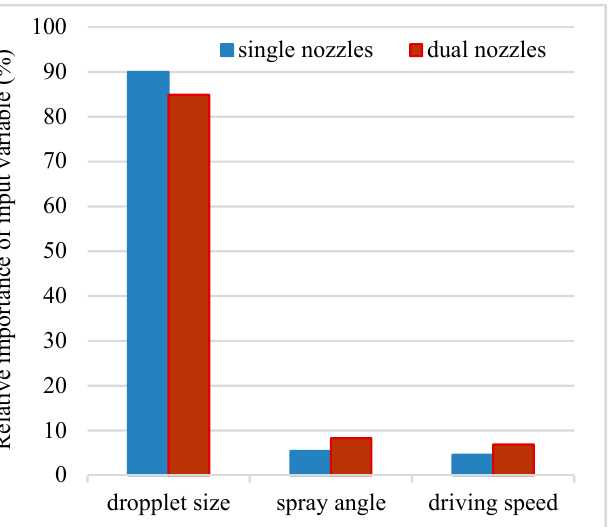
Figure 8. The relative importance of the input variables of the MLP model on the average degree of coverage.